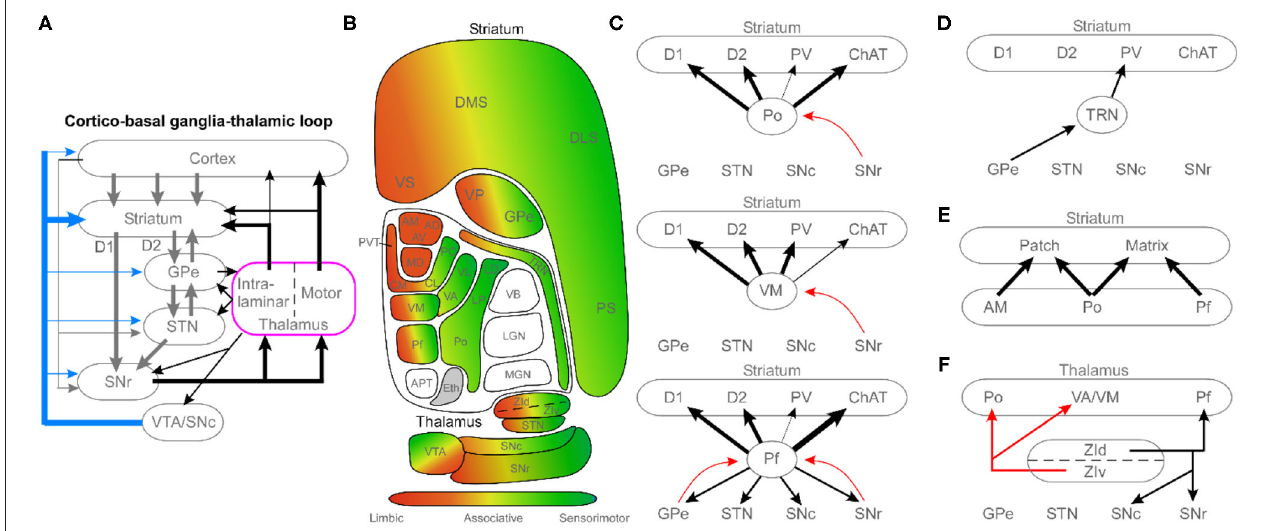
FIGURE 1 | Circuit diagrams illustrating the complex diversity of thalamic connections with the basal ganglia. (A) Schematic of the cortico-basal ganglia-thalamic loop, highlighting the central role of the thalamus as a major recipient of basal ganglia output, and an important source of basal ganglia inputs. (B) Diagram of the topographic organization of the thalamus and basal ganglia, organized by limbic, associative, and sensorimotor regions. (C) Circuit diagrams illustrating differences among higher-order thalamic nuclei, motor thalamus, and caudal intralaminar thalamic nuclei. Diagrams feature cell-type specific innervation of the striatum (D1, direct pathway medium spiny neurons; D2, indirect pathway medium spiny neurons; PV, parvalbumin interneurons; ChAT, cholinergic interneurons) and unique patterns of connectivity with other basal ganglia nuclei. Black arrows, excitatory projections; red arrows, and inhibitory projections. (D) Connectivity of the thalamic reticular nucleus (TRN). (E) Relationship of three thalamic nuclei (limbic: AM; higher-order: Po; intralaminar: Pf) with respect to the patch (striosome) and matrix compartments of the striatum. (F) Connections of the zona incerta (ZI) that mediate interactions between the thalamus and basal ganglia. See the article text for references regarding the anatomical connectivity. Black arrows, excitatory projections; red arrows, inhibitory projections. APT, anterior pretectal nucleus; AD, anterodorsal nucleus; AM, anteromedial nucleus; AV, anteroventral; CM, centromedial nucleus; CL, centrolateral nucleus; DLS, dorsolateral striatum; DMS, dorsomedial striatum; Eth, ethmoid; GPe, globus pallidus external; LD, lateral dorsal nucleus; LGN, lateral geniculate nucleus; LP, lateral posterior; MGN, medial geniculate nucleus; Pf, parafascicular nucleus; PC, paracentral nucleus; PS, post-commissural striatum; PVT, periventricular thalamic nucleus; Po, posterior nucleus; SNc, substantia nigra pars compacta; SNr, substantia nigra pars reticulate; STN, subthalamic nucleus; TRN, thalamic reticular nucleus; VB, ventrobasal complex; VA, ventroanterior nucleus; VL, ventrolateral; VM, ventromedial nucleus; VP, ventral pallidum; VS, ventral striatum; VTA, ventral tegmental area; ZId, zona incerta dorsal; ZIv, zona incerta